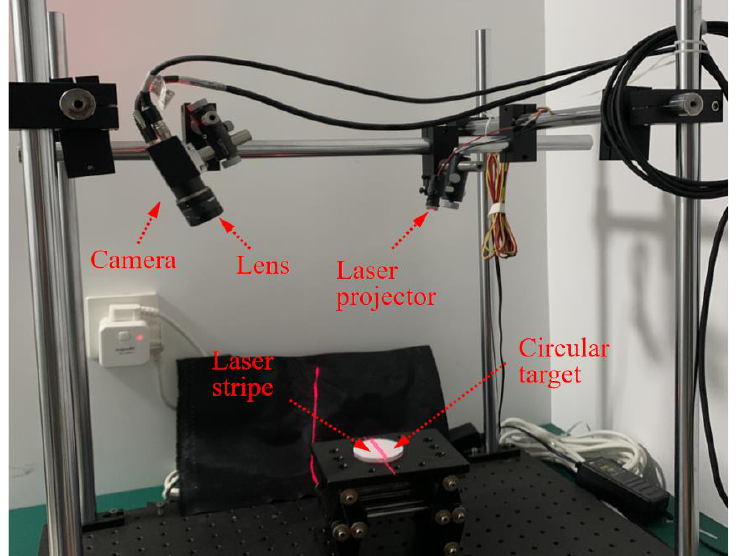
Figure 10. Experimental setup.